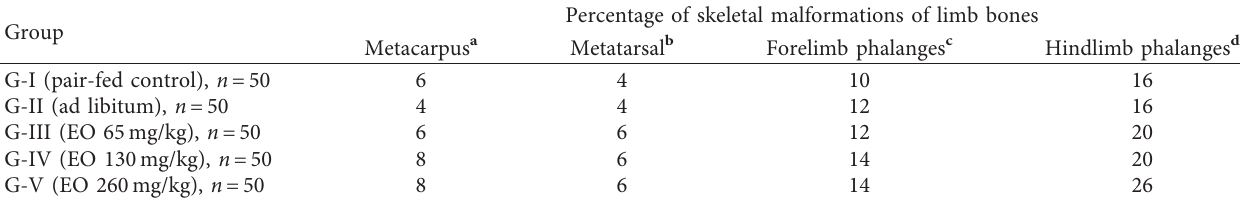
Table 10: Skeletal malformations of a 20-day-old rat fetuses following treatment with the essential oil of Thymus schimperi . Group